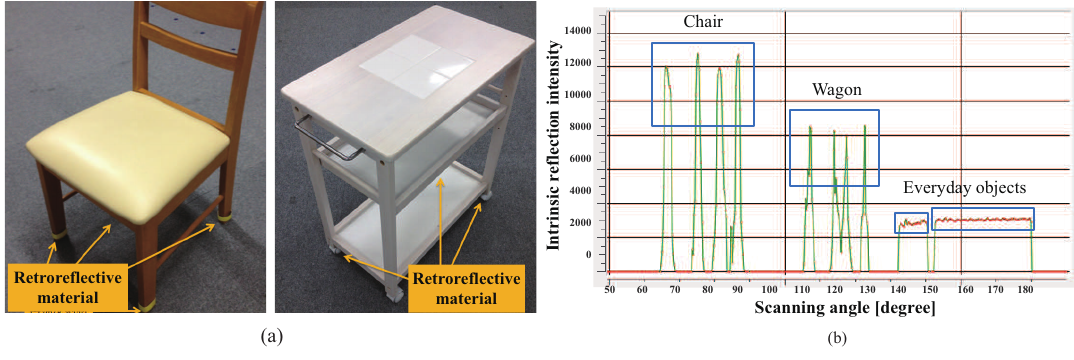
Figure 9. Attaching retroreflective materials and position measurement using reflected laser beam and diffused laser beam: ( a ) position of retroreflective material, ( b ) distinctly different intensity compared to the other